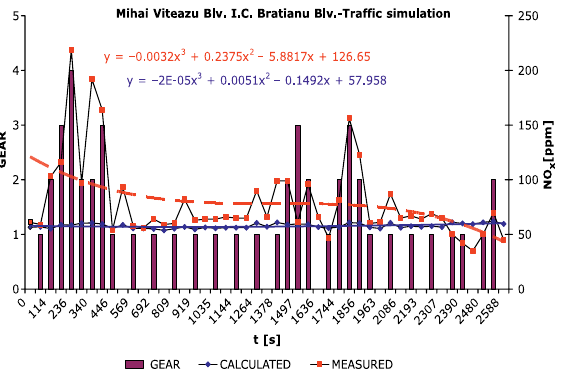
Fig. 7. NO x emission versus time for petrol fuel (air conditioning unit is turned